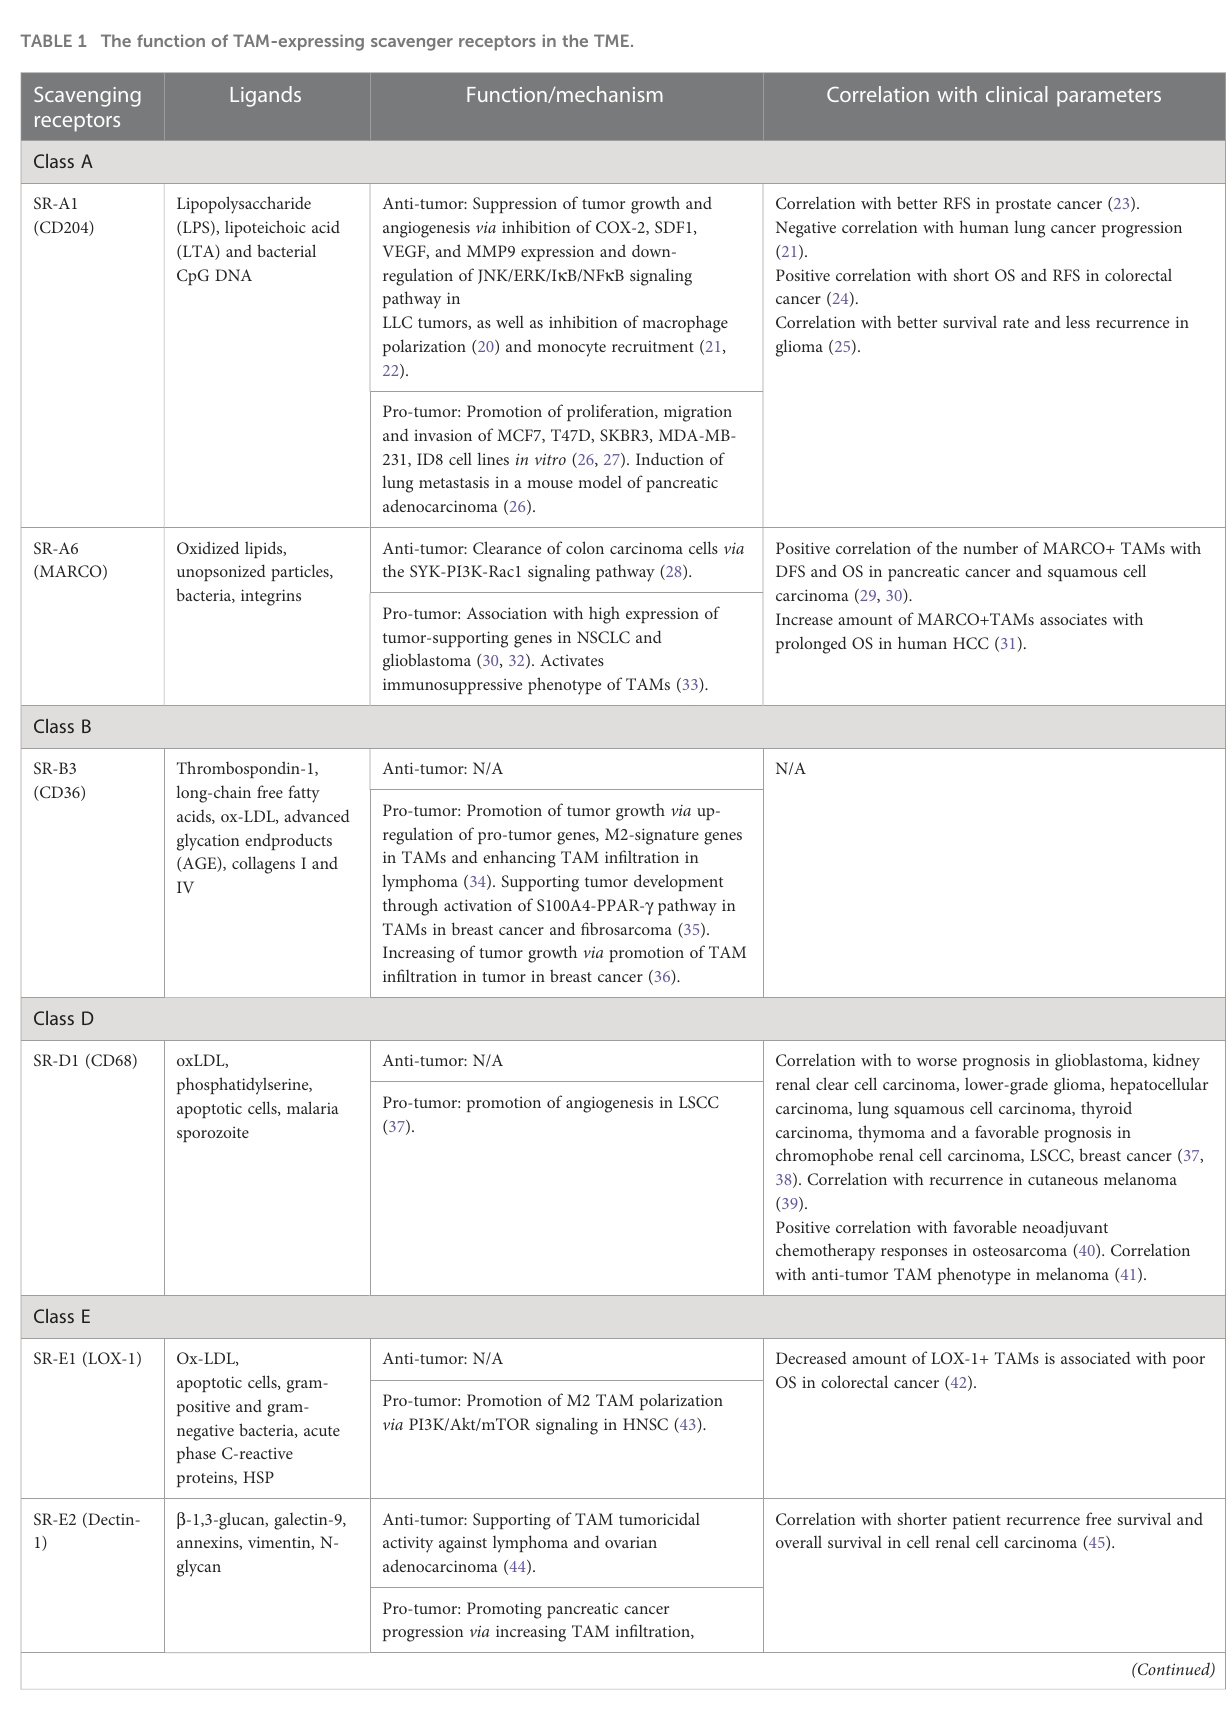
TABLE 1 The function of TAM-expressing scavenger receptors in the TME.